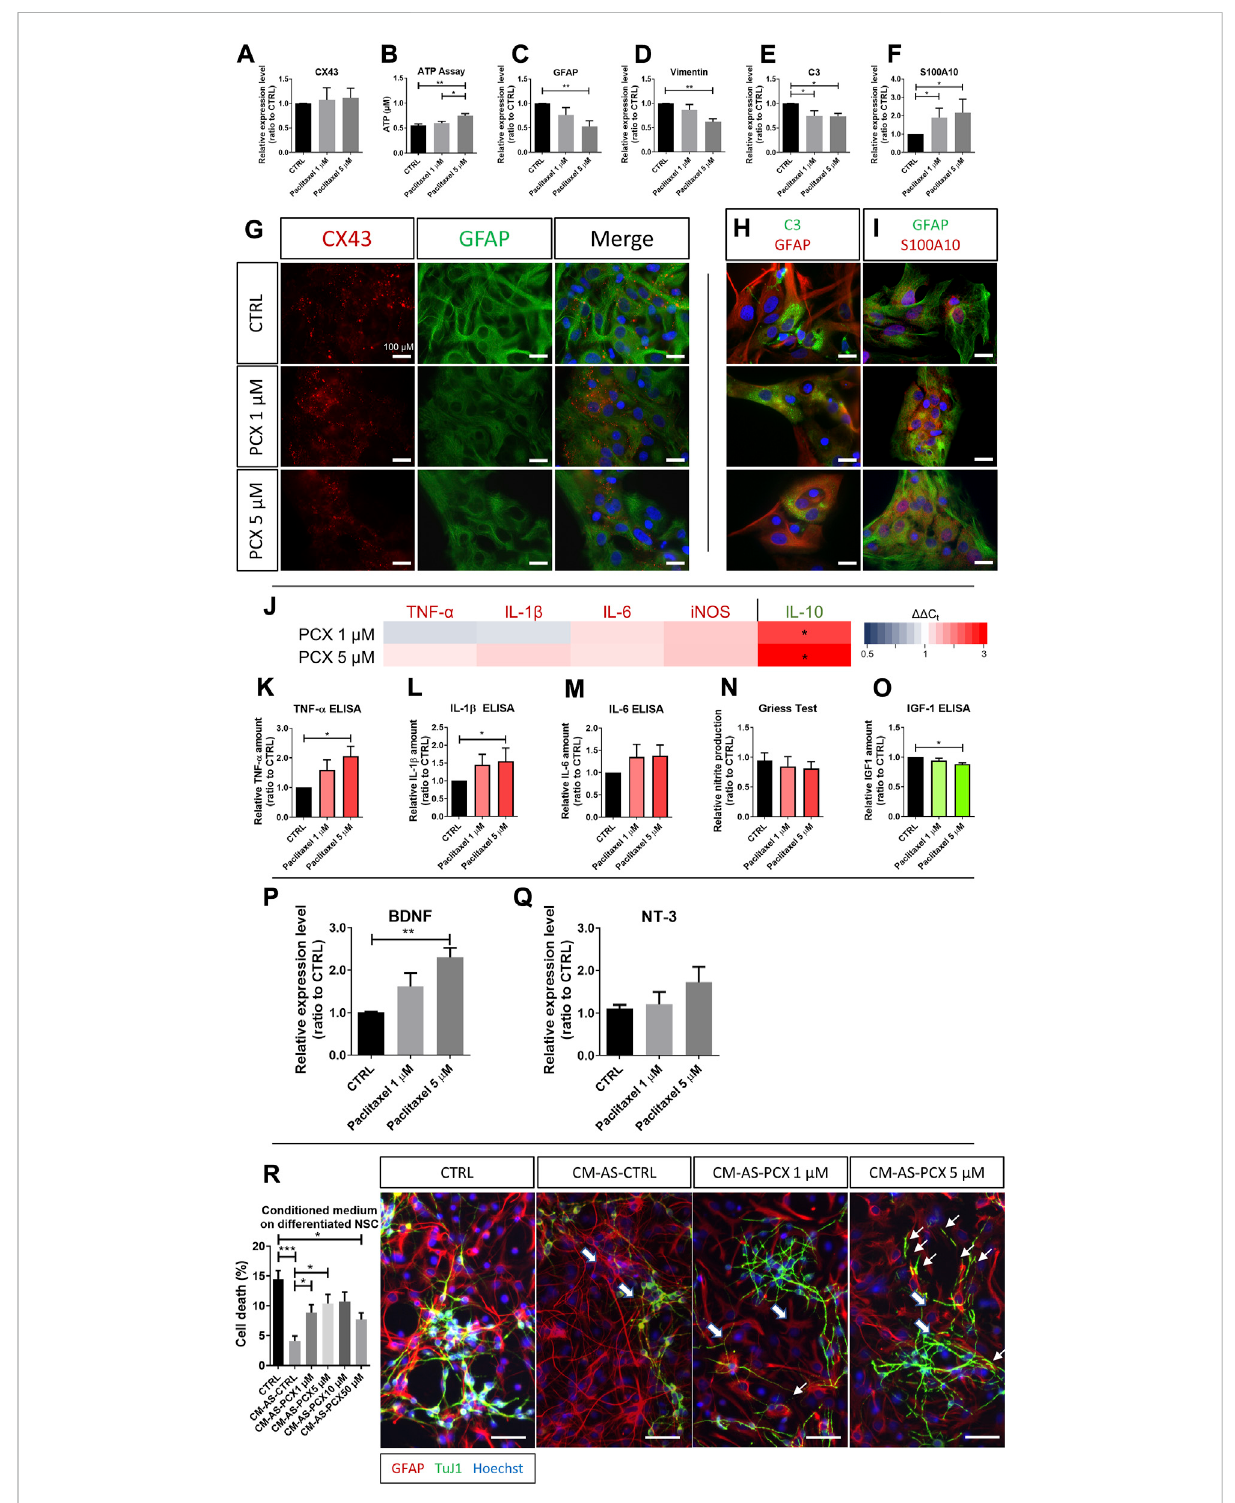
FIGURE 3 Effects of paclitaxel on astrocytes. (A) Relative expression level of Connexin 43 (CX43) in astrocytes after 1 μ M and 5 μ M paclitaxel exposure compared to control ( n (number of independent cell culture preparations) = 6). (B) Released adenosine triphosphate (ATP) in μ M after paclitaxel exposure with 1 μ M and 5 μ M compared to untreated (CTRL) cells ( n (number of biological replicates) = 17). (C) Relative expression level of glial fi brillaryacidicprotein(GFAP)inastrocytesafter1 μ Mand5 μ Mpaclitaxelexposurecomparedtocontrol( n